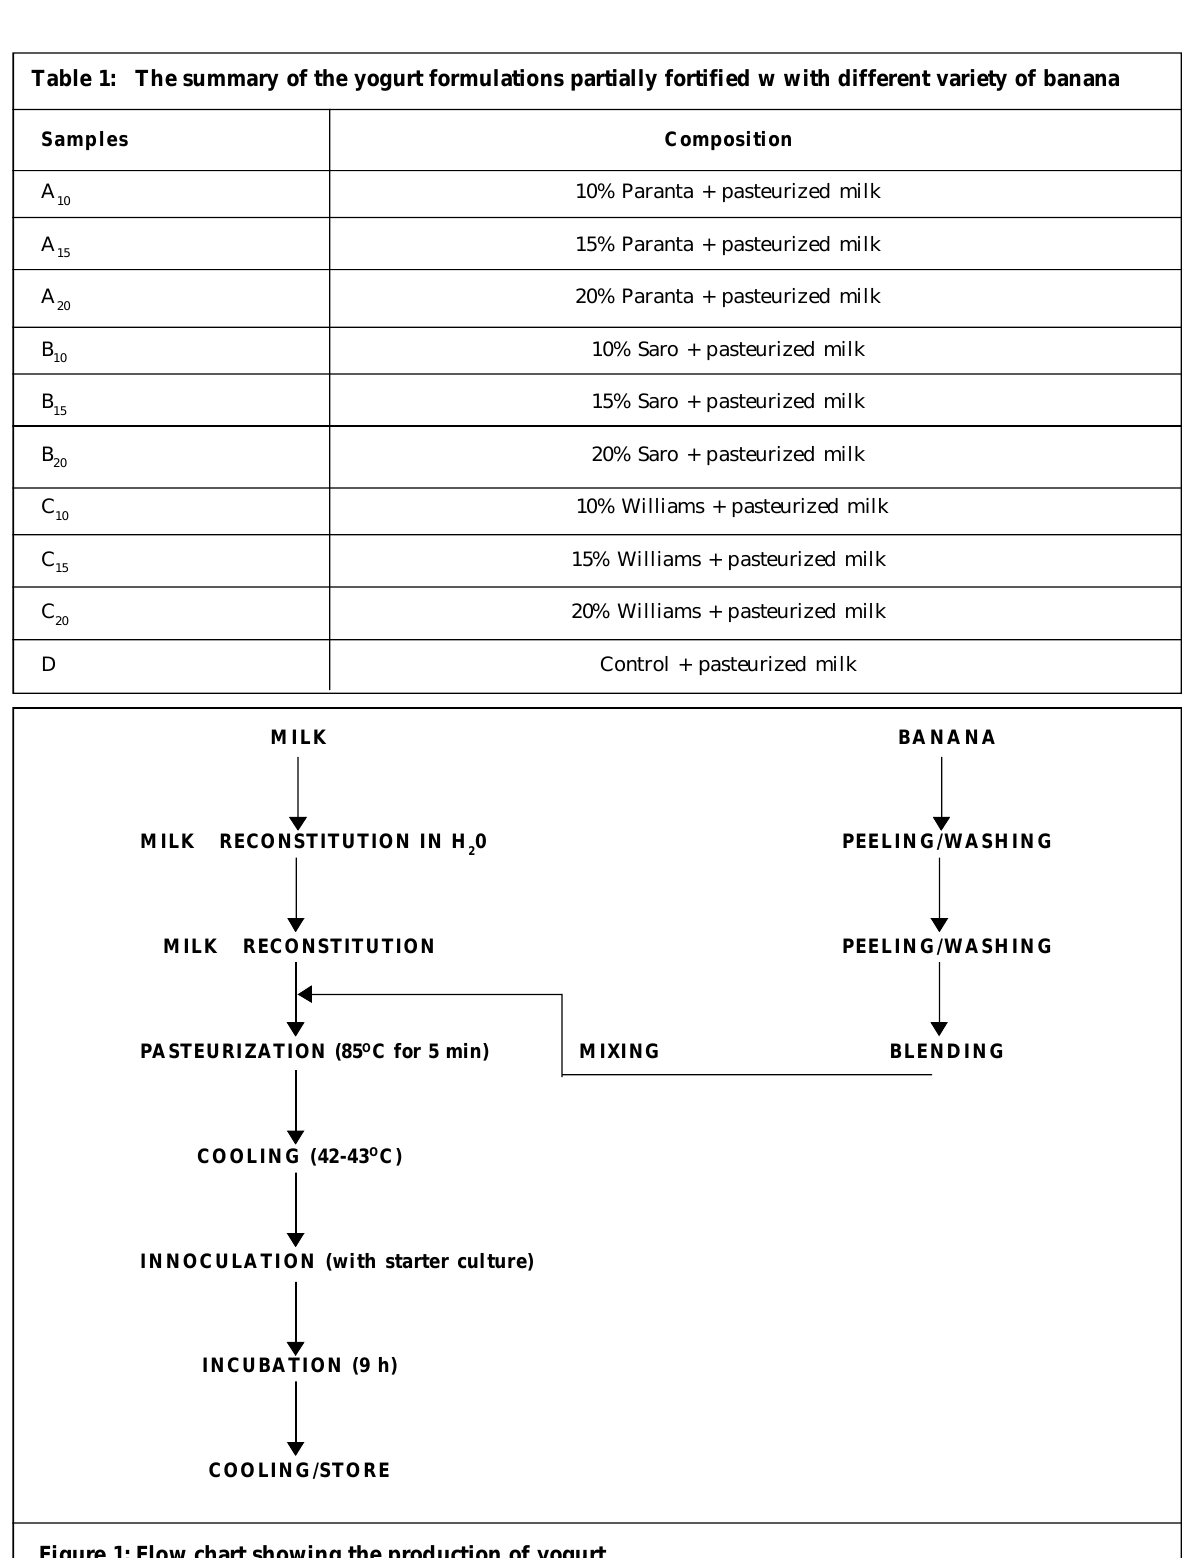
Figure 1: Flow chart showing the production of